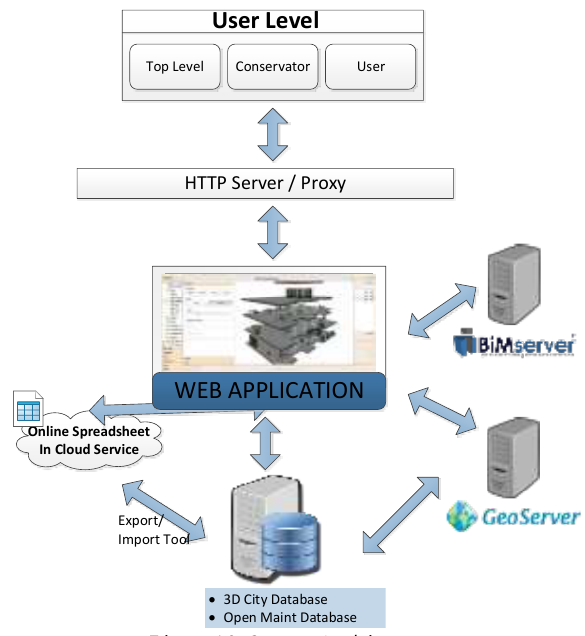
Figure 16. System Architecture